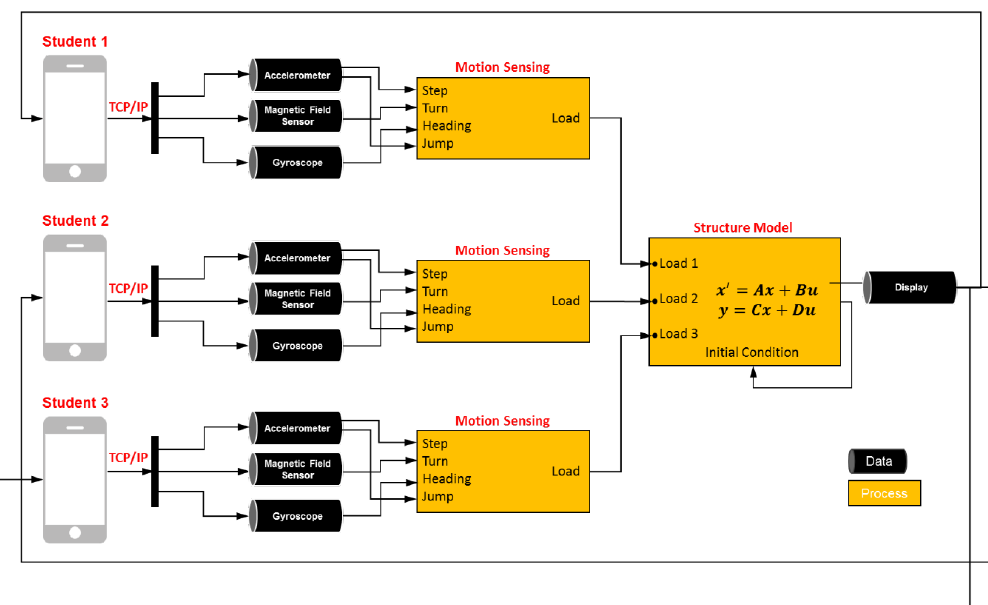
Figure 2. Overview of the proposed system.